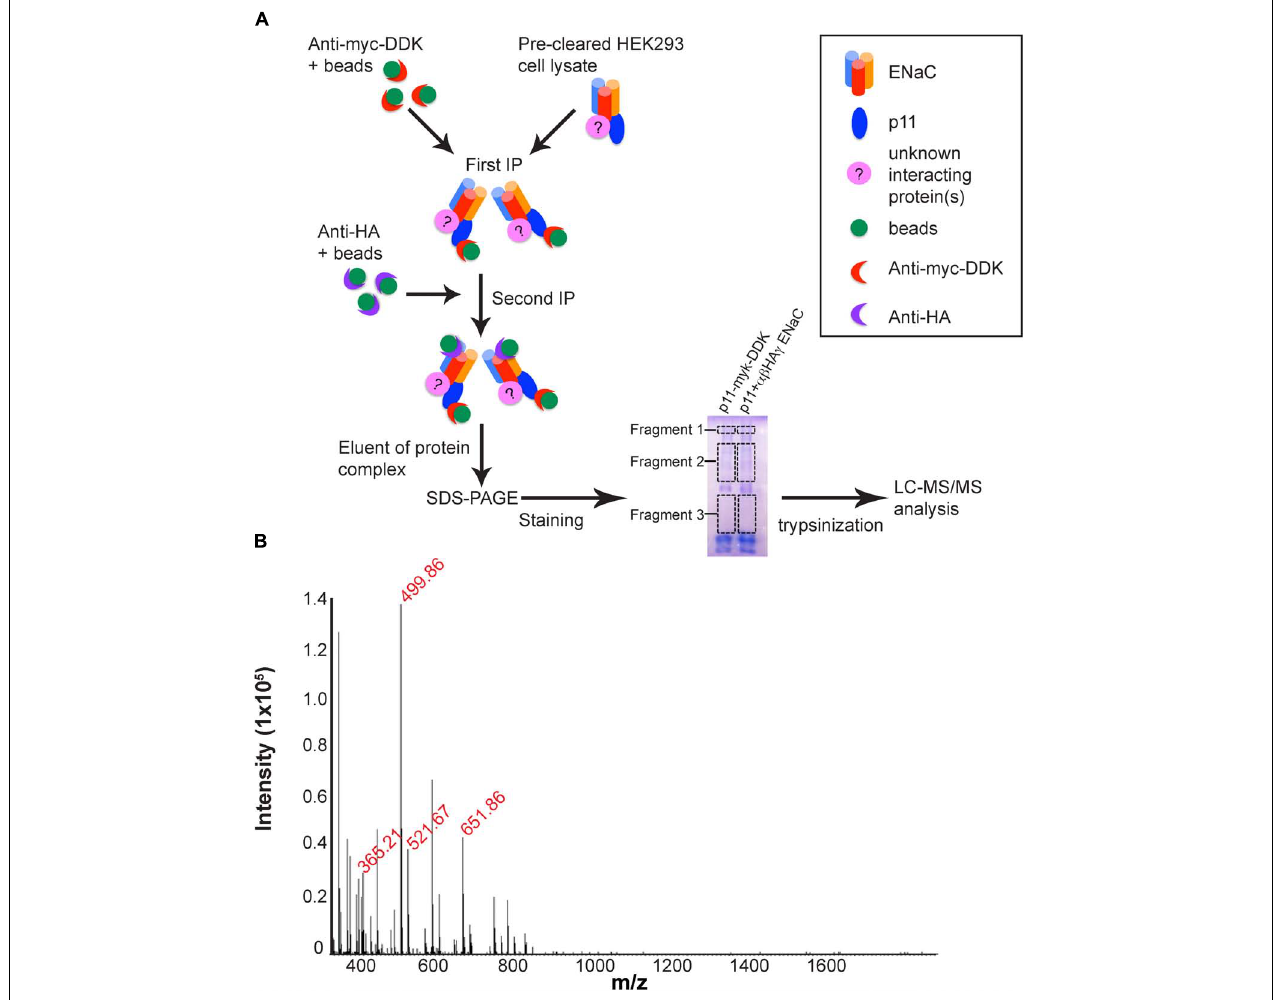
FIGURE 3 | Identification of novel p11-ENaC interacting partners by LC–MS/MS analysis. (A) Schematic representation of the proteomics approach used to identify proteins interacting with the p11-ENaC complex. HEK293 cell lysates were co-transfected with p11-myc-DDK and αβ -HA γ ENaC. After 24 h expression, cells were lysed and co-immunoprecipitated sequentially with anti-myc-DDK and anti-HA with additional protein G-agarose beads in each tube. The eluent of the complex was then collected and subjected to SDS-PAGE 1D gel. The gel was carefully excised into three fragments and processed through in-gel trypsinization for LC–MS/MS analysis to determine potential proteins interacting with ENaC and p11. (B) MS spectrum recorded during analysis of purified protein complexes. Red text denotes specific peptides that identified proteins listed in Table 1 . The list of identified peptides was used to tag the corresponding peptide-related ion spectra based on m/z differences, deviations from the predicted elution times, and the match between the theoretical and observed isotopic envelopes. The maximum deviation accepted in m/z and the retention time was established separately for each of the processed LC–MS spectra to account for possible variations in mass measurement accuracy and chromatographic separation between runs.